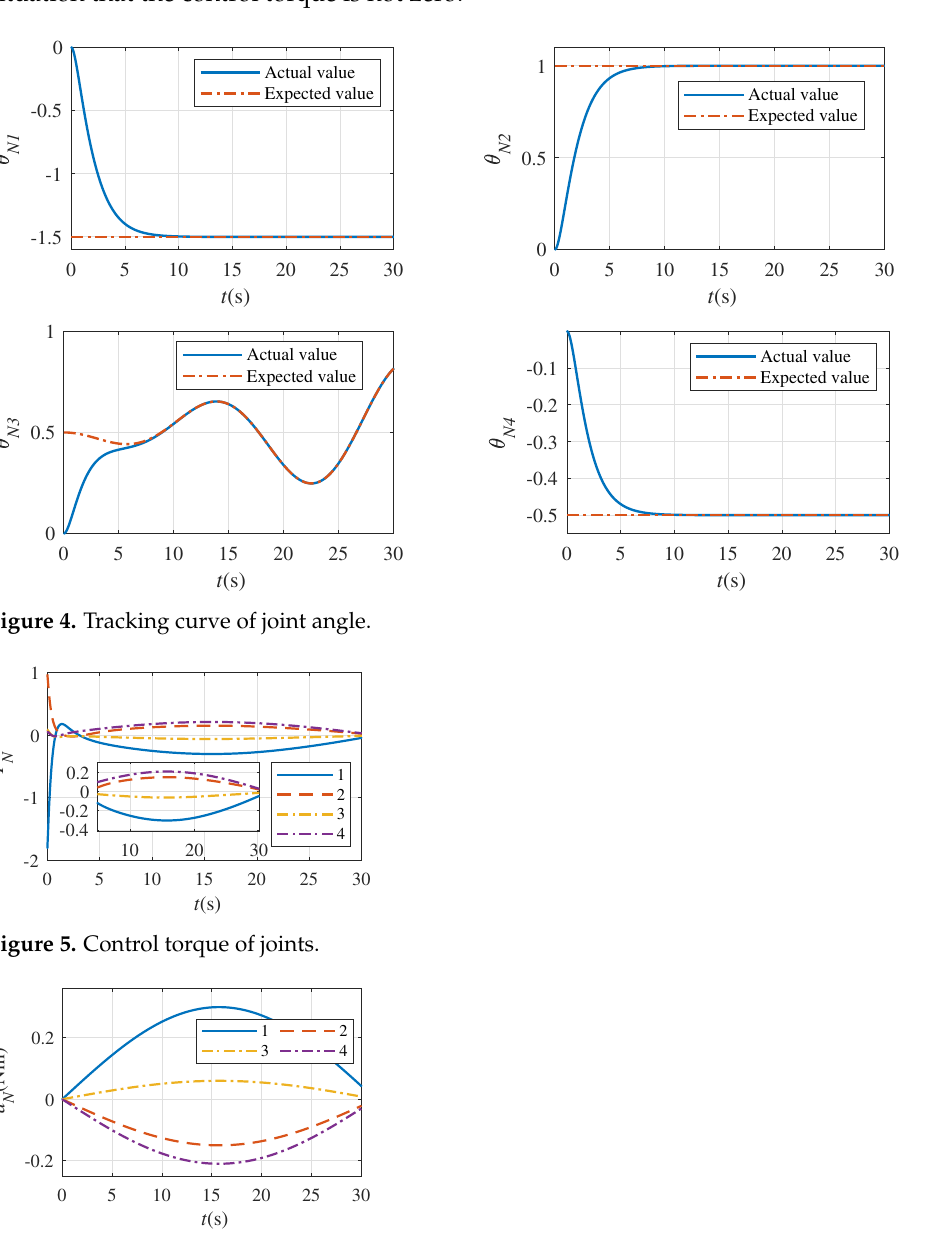
Figure 6. Disturbance torque of